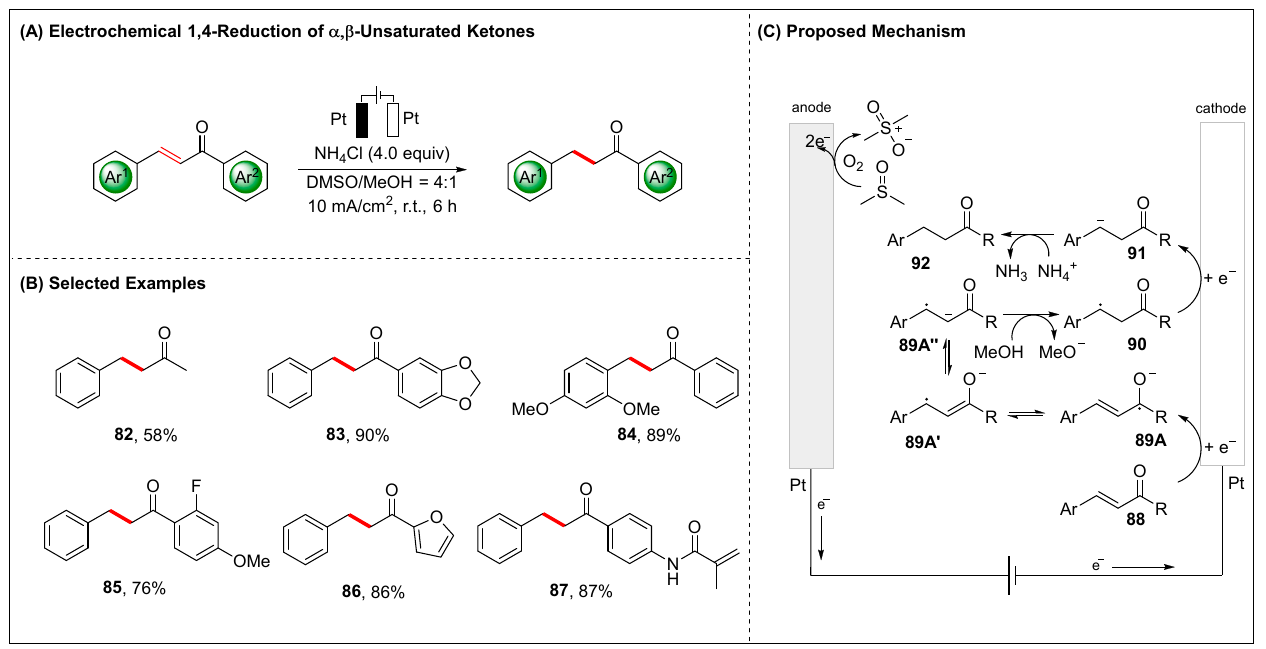
Figure 10. Electrochemical 1,4-reduction of α , β -unsaturated ketones with MeOH and NH 4 Cl as hydrogen sources.